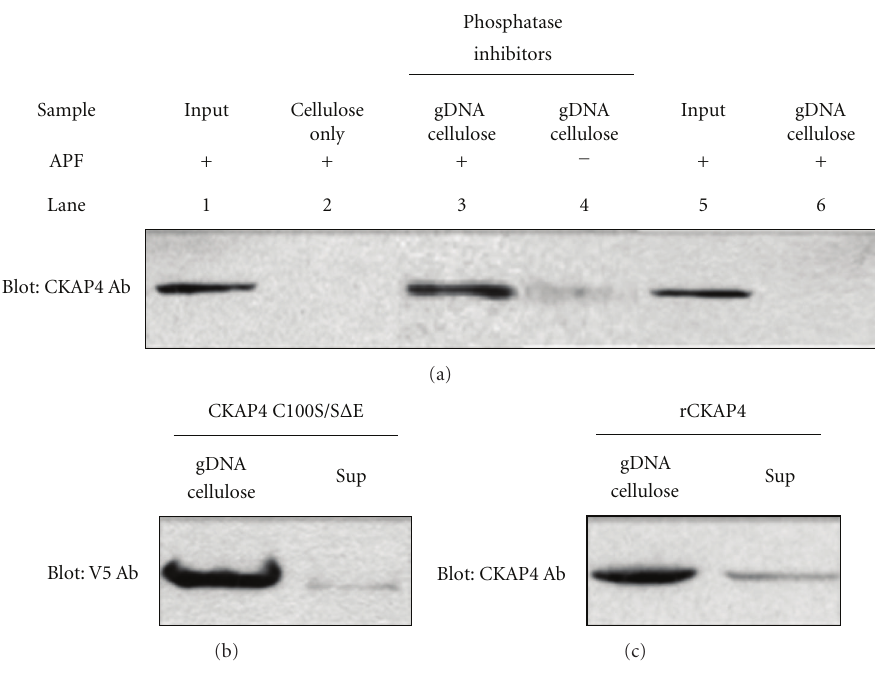
Figure 7: CKAP4 binds directly to genomic DNA . (a) CKAP4 binds gDNA in an APF-dependent manner (lane 3) when compared to mock-treated control (lane 4). The CKAP4-gDNA binding is phosphorylation dependent as CKAP4 isolated from cells treated without phosphatase inhibitors prior to APF treatment failed to bind gDNA (lane 6). As controls, we loaded APF treated nuclear lysates in lane 1 and phosphatase/APF treated lysates in lane 5. Lane 2 is a no gDNA cellulose control. (b) The ability of transiently transfected V5-tagged, CKAP4 C100S/S Δ E to bind gDNA in the absence of APF treatment (c) and the ability of purified rCKAP4 (residues 126–501, which includes the bZIP-like DNA-binding domain) to bind gDNA were also assessed by comparing the amount of CKAP4 captured relative to what remained in the cell lysate after binding